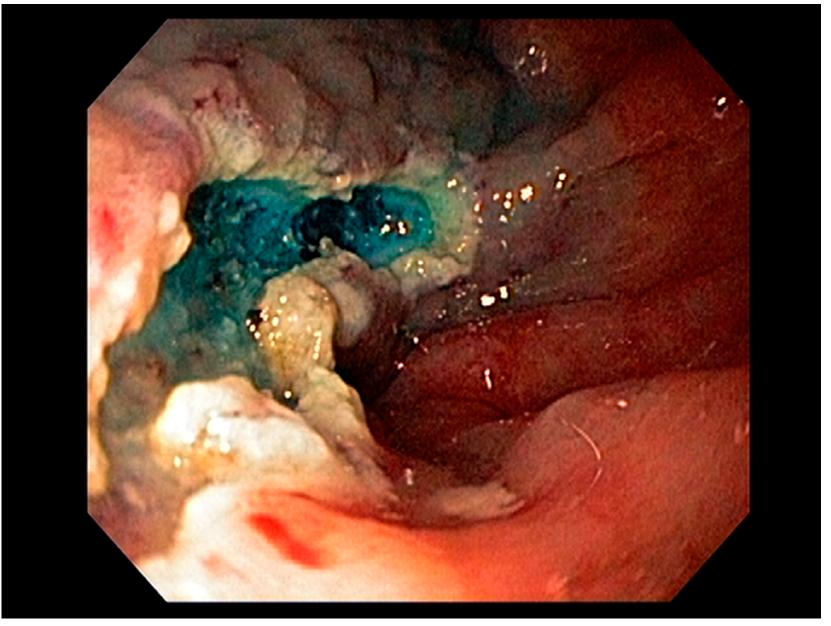
Figure 10. EMR of Early Gastric Cancer (EGC); submucosa stained with methylene blue.